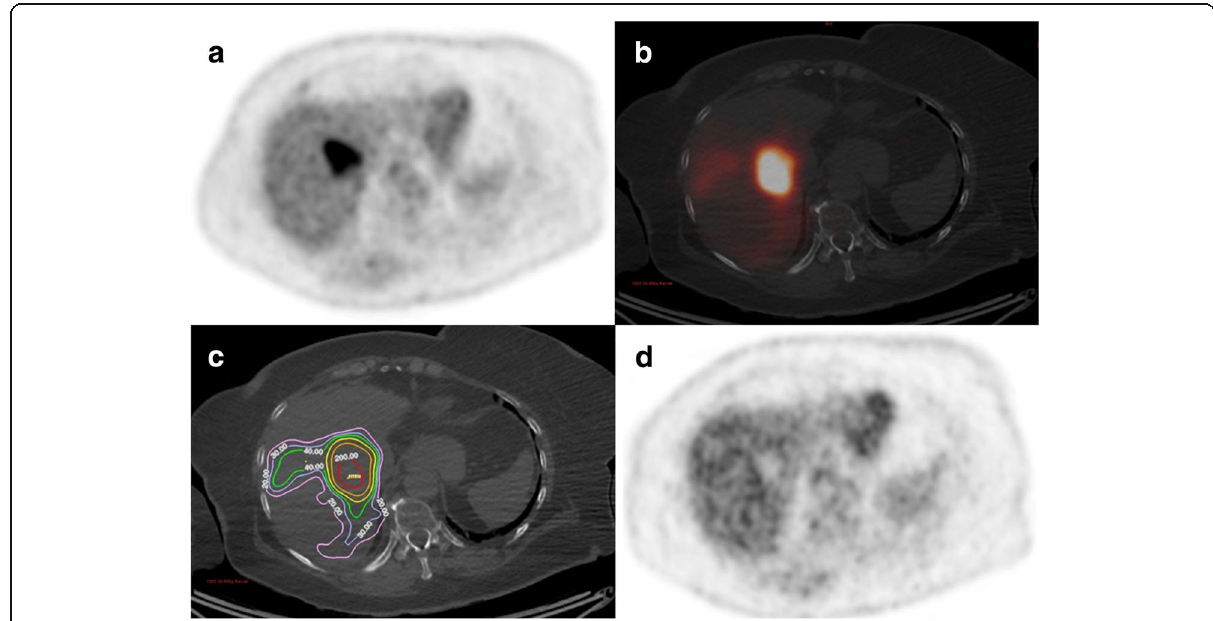
Fig. 3 Registered axial images of a patient with liver mCRC. a Baseline FDG-PET shows the target lesion located in segment VIII. b 90 Y-PET/CT images after supra-selective SIRT administered in the right hepatic artery, showing a high 90 Y-microsphere uptake. c 90 Y-microsphere absorbed dose map showing that the lesion receives a high absorbed dose ( D mean = 268 Gy). d Follow-up FDG-PET obtained at 6 weeks post-SIRT indicating a complete response